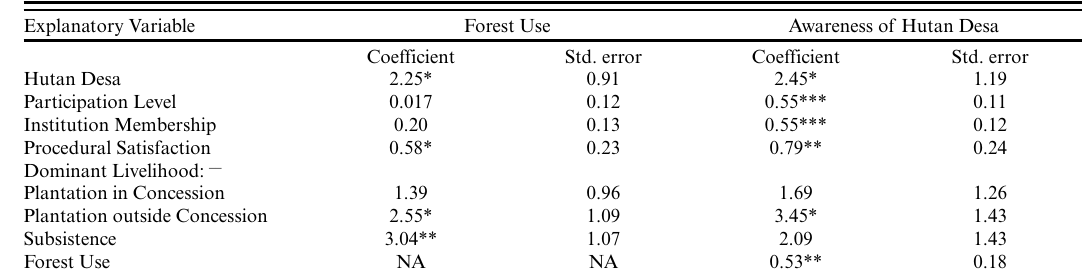
Table 4 . Empirical results from generalized linear mixed models of forest use and awareness of Hutan Desa permitting status. Note that the reference level for dominant livelihood is other sectors.